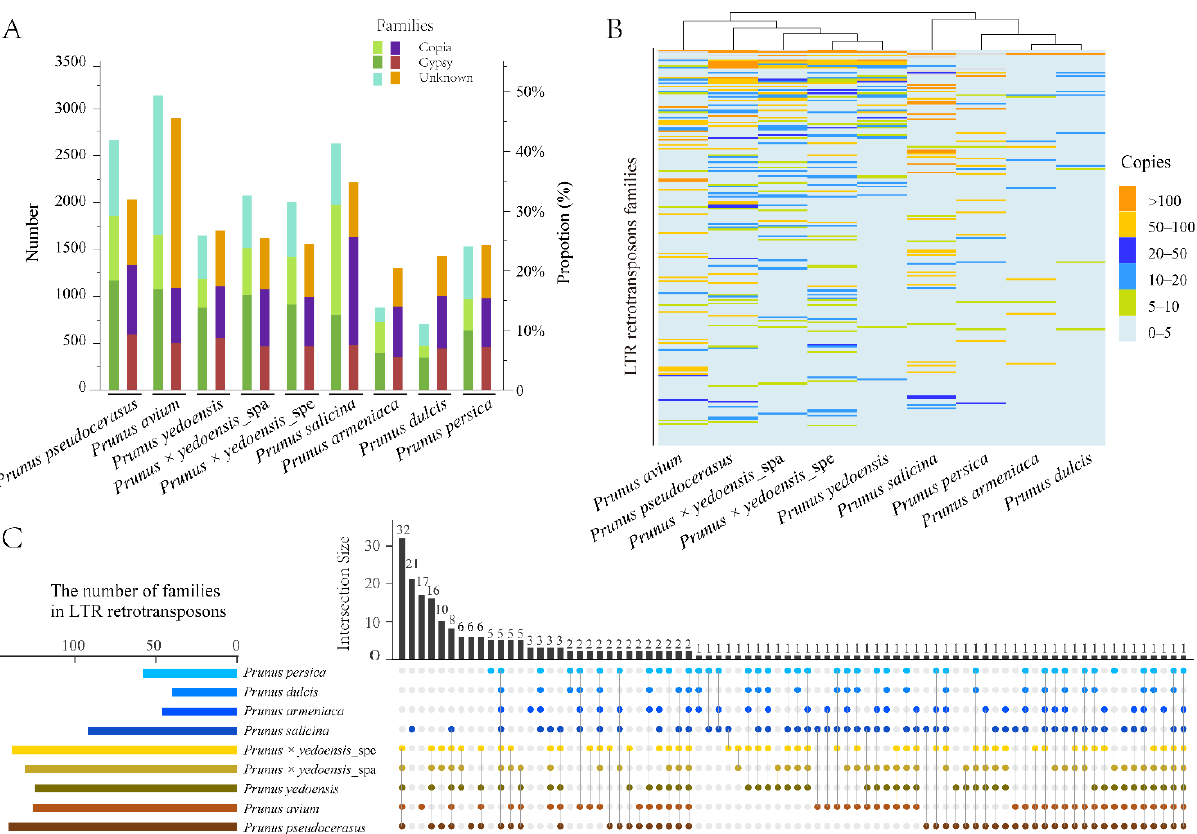
Figure 1. Analyses of LTR-RTs in nine haploid genomes. ( A ) The copy numbers (N) of full-length LTR-RTs and proportions (P) of TLR-RT content in genomes. ( B ) Copy number differences of full- length LTR-RTs in different clusters among genomes. ( C ) UpSetR of the LTR-RT clusters shared by the Prunus subgenus Cerasus and its relatives. Intersection sizes on the vertical bars represent the numbers of LTR-RT clusters for a given pattern. The horizontal bars on the left show the whole clusters of LTR-RTs detected in each species. Datasets appearing in intersections are shown with spots.